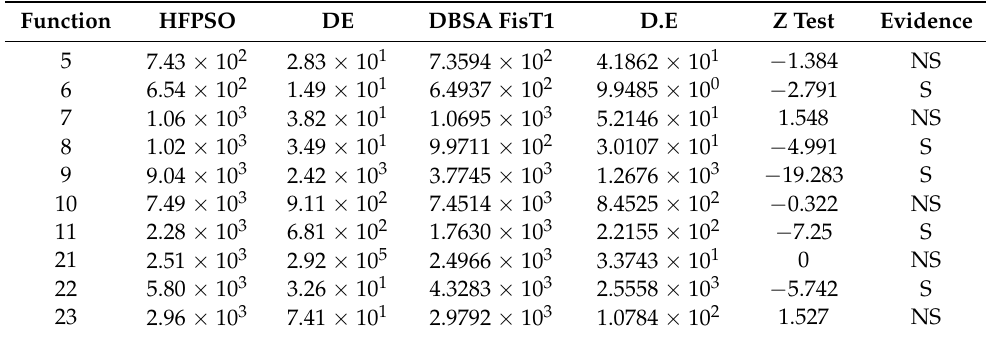
Table 14. Statistical test results for CEC2017 functions using type-1 fuzzy